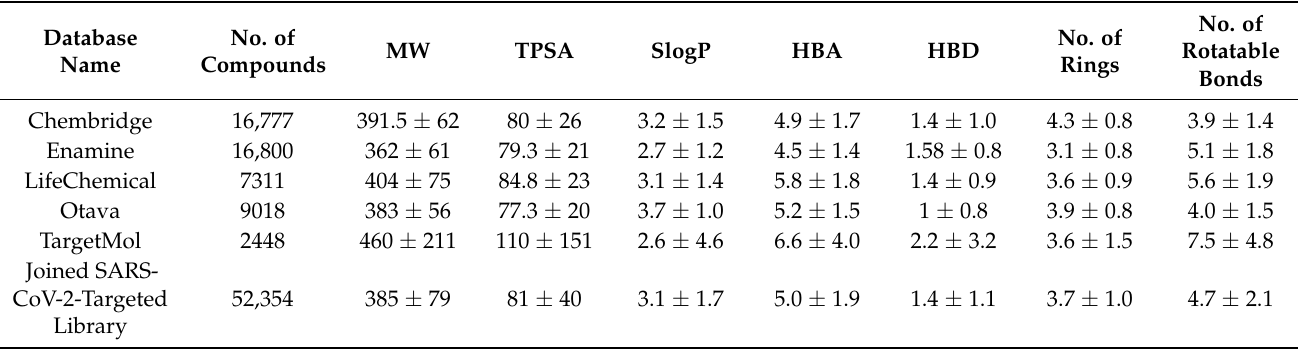
Figure 7. Process algorithm for generating the TargetMol SARS-CoV-2-targeted molecular library. For each library described, we performed an analysis of the most common molecular descriptors that were found to be relevant [80]: Molecular Weight (MW), Total Polar Surface Area (TPSA), SlogP, number of hydrogen bond acceptors (HBA), number of hydrogen bond donors (HBD), number of rings present and the number of rotatable bonds (Table 2). Compound retention when passing through each individual filter was assessed, as well (Table 3), with the results for joined filter provided in Figure 8. Table 2. Analysis of the most important descriptors for the SARS-CoV-2-targeted library.